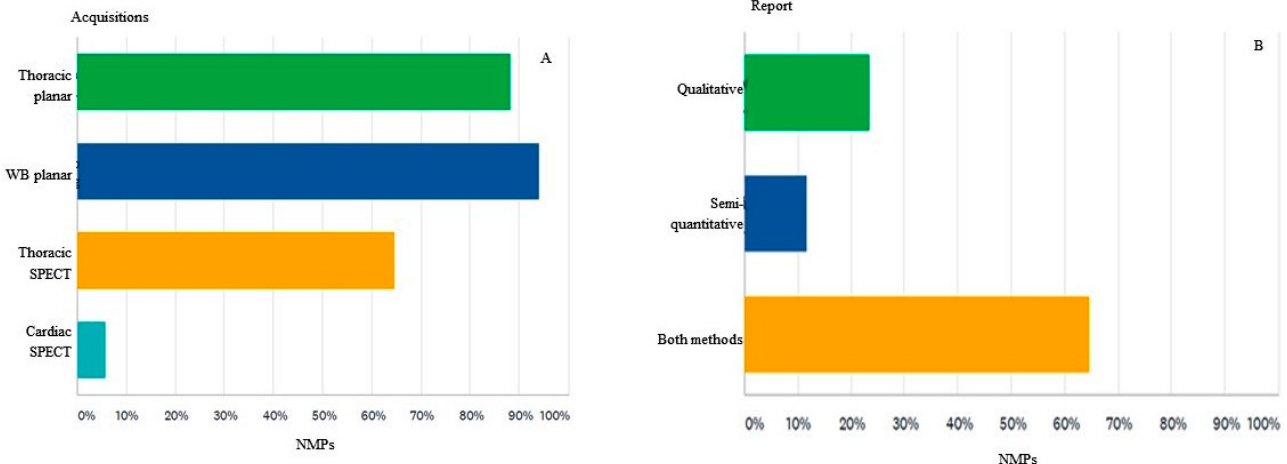
Figure 8. ( A ). Image acquisition protocol, part of the imaging protocol in CA-ATTR diagnosis. Thoracic planar = Acquisition of image in the same plane in antero-posterior and oblique incidents. WB planar = Incidents in the same plane anterior and posterior whole body (vertex-soles). SPECT = Single photon-emission computed tomography at the thorax. Cardiac SPECT = Single pho- ton-emission computed tomography only at the level of the heart. ( B ). Reporting the uptake of 99mTc-bisphosphonate in the